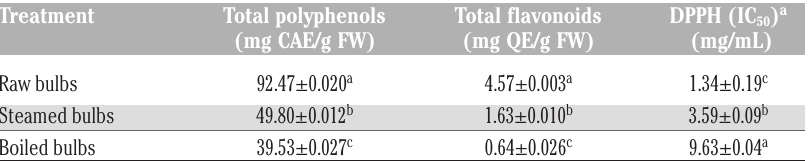
Table 1. Total polyphenol and flavonoid content and antioxidant activity evaluated by ascorbic acid method of extracts of raw and cooked lampascioni ( Muscari comosum ).